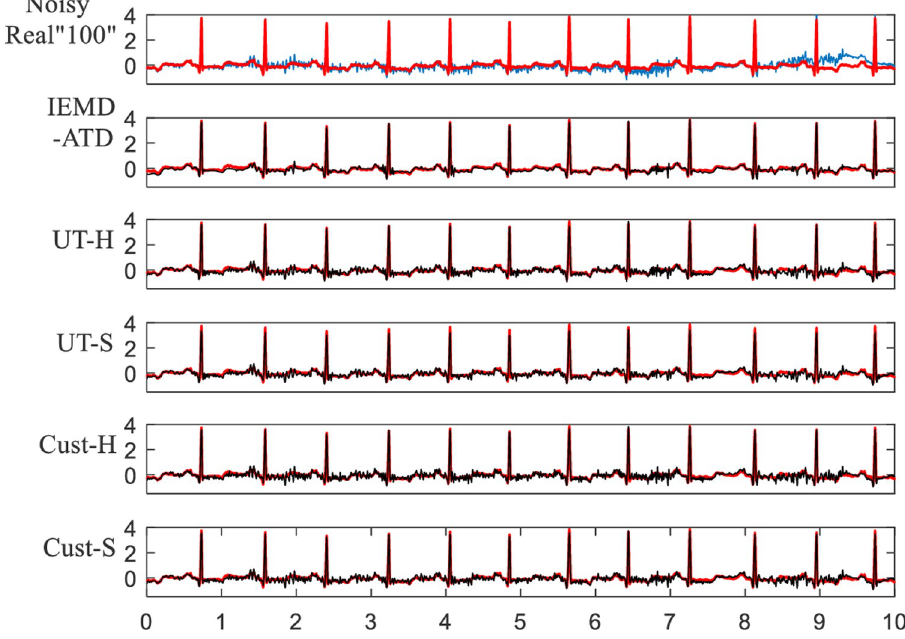
Fig 13. Waveforms of denoised ECGs for real “100” with EMG noise at 5 dB for the 5 denoising methods.